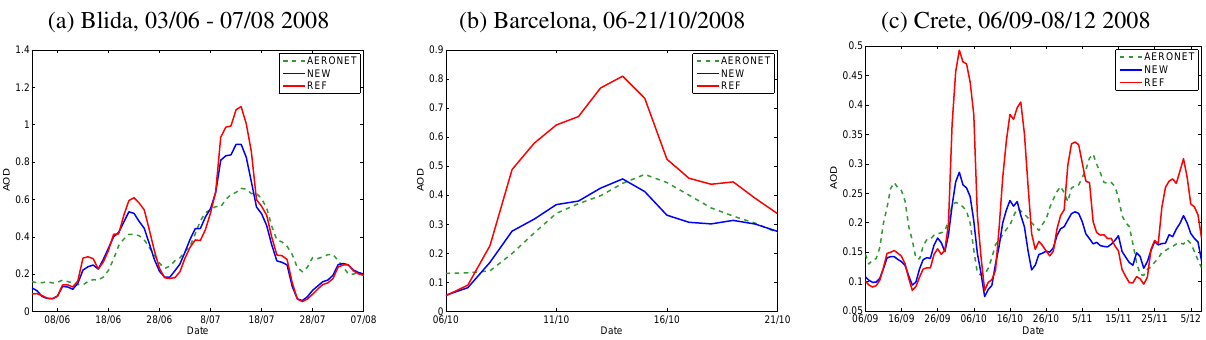
Fig. 7. Comparisons of AOD at 550nm between AERONET measurements and REF (red line) and NEW (blue line) experiments at three different locations: Blida (a) , Barcelona (b) and Crete (c) . Time series of AOD values (dashed green lines) represent seven-day-averaged daily values.